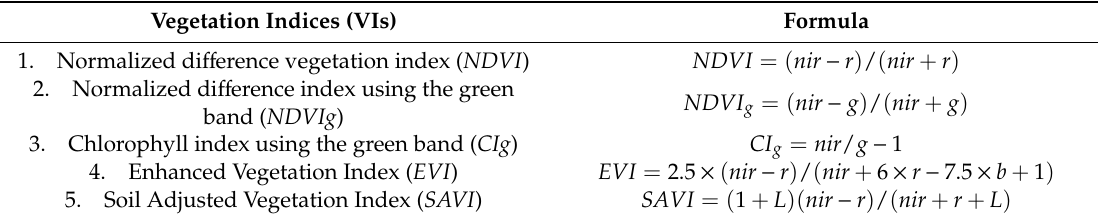
Table 2. Vegetation indices and its formula.